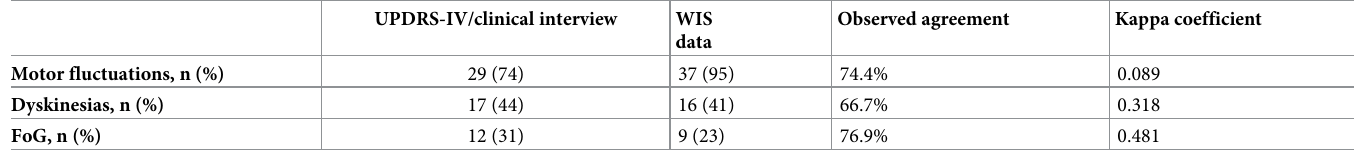
Table 3. Observed agreement between UPDRS-IV and wearable inertial sensor, regarding motor fluctuations, dyskinesia and FoG (at